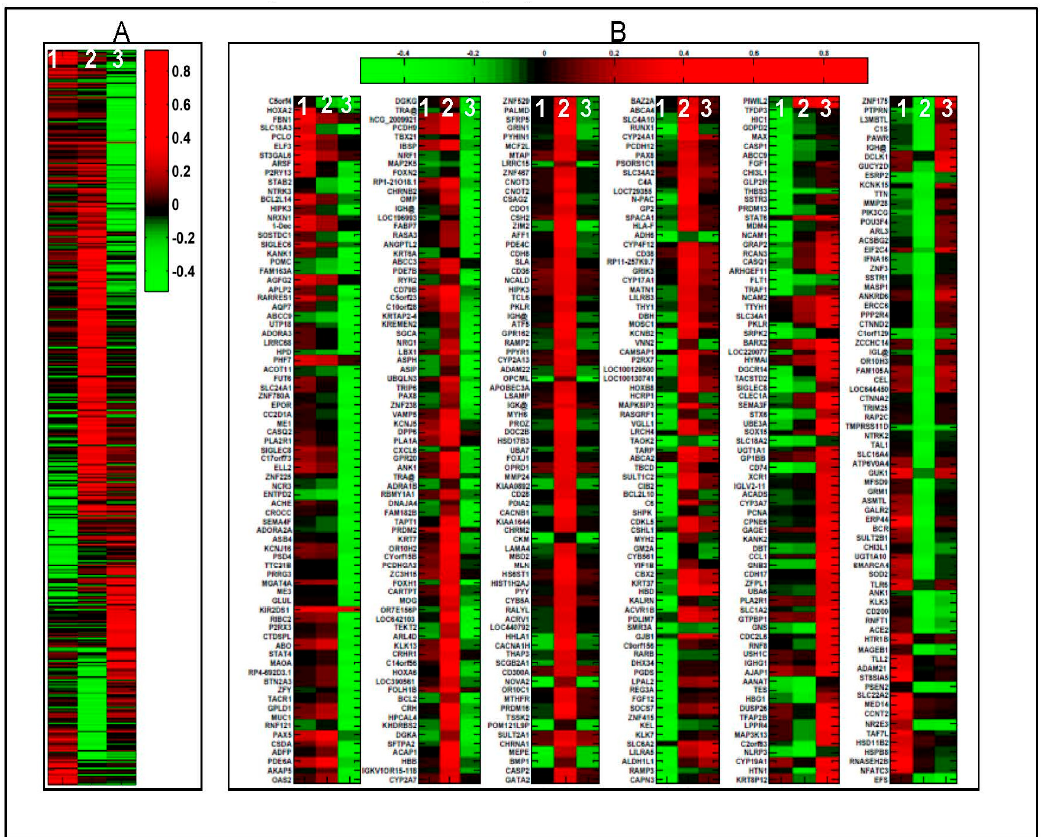
Figure 1. Heat map of Vitamin D target genes in 143B Osteosarcoma (OS) cells. Heat map of 1 α ,25(OH) 2 D 3 induced gene expression fold changes ( A ) along with the names of the vitamin D-target genes ( B ) in 143B human OS cells during proliferation, post-proliferation, and differentiation relative to control (vehicle). Color bar represents log fold change values, red indicates up-regulated while green represents down regulated genes. Numbers 1–3 represents different growth stages of 143B cells post vitamin D treatment vs. control (ethanol or vehicle treated), namely proliferation, three days; post proliferation, nine days; and differentiation, 14 days. The colors red and green indicate genes that are up and down regulated, respectively.